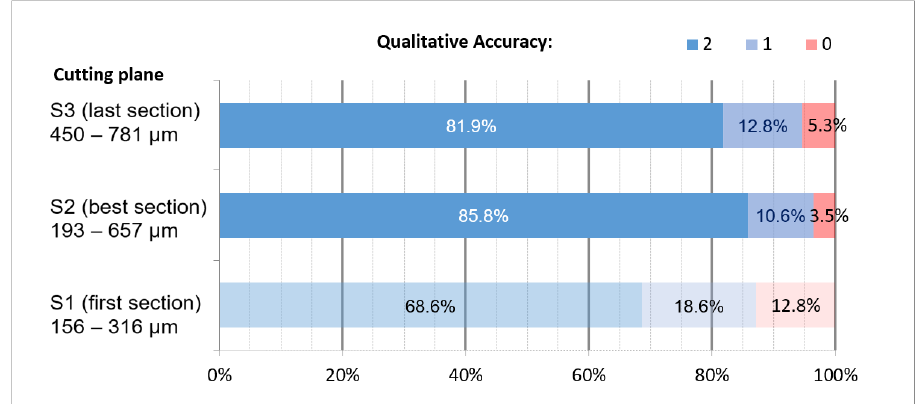
Figure 5. Qualitative Accuracy regarding the Cutting plane. Colours for the S1 plane are deliberately more faint because it did not always contain all punched cores already, since the top of each core is not necessarily precisely in the same sectional plane. This circumstance limits the comparability of the S1 data. The number 2 indicates that the target was completely hit, number 1 indicates a partially hit, 0 indicates that the target was missed.